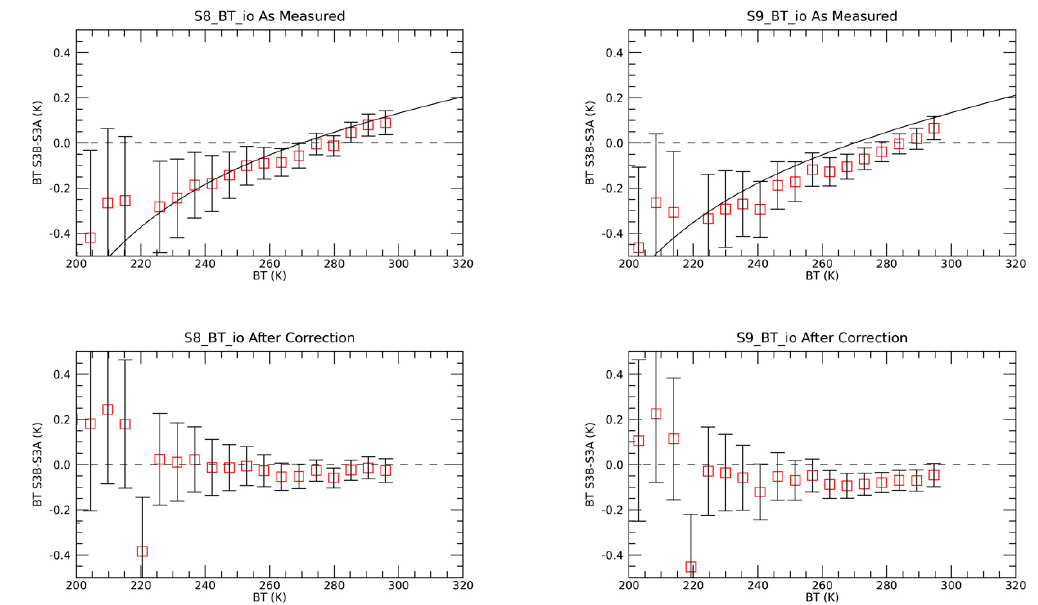
Figure 6. Differences in oblique view S8 ( left column ) and S9 ( right column ) brightness temperatures (reprinted from [25]). The top-frames show the as-measured results compared against the stray-light model. The lower frames show the results after correction.